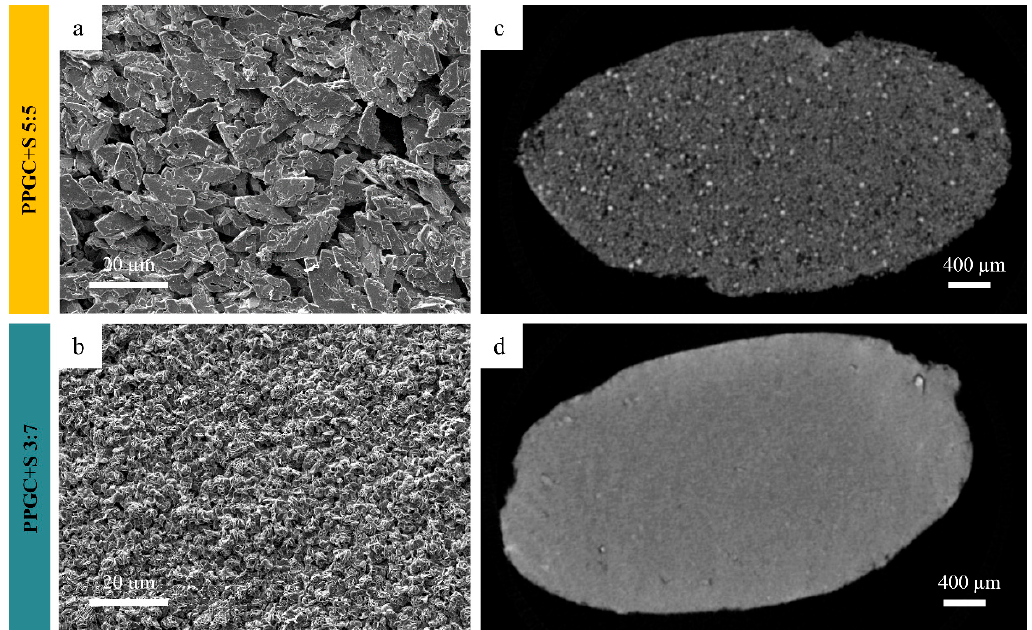
Figure 1. SEM images ( a , b ) of just precipitated and dried mineral and µ-CT ( c , d ) of the final specimen of phosphate prestructured gelatin mineralized with calcium and strontium ions in the molar ratio of 5:5 and 3:7. µ-CT shows a sectional plane in the base of the specimen (compare Figure 12d).